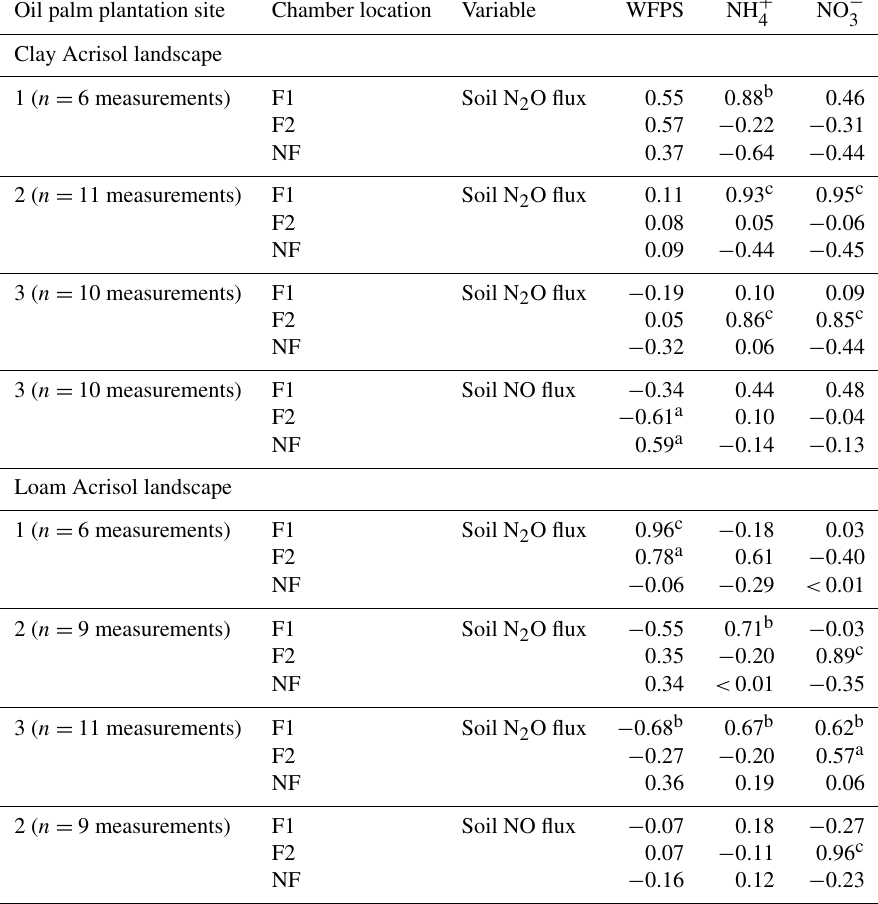
Table 4. Pearson correlation coefficients ( n = 6–11 measurements following fertilization) between N-oxide fluxes (µgNm − 2 h − 1 ), water- filled pore space (WFPS; %, top 0.05m depth) and extractable mineral N (mgNkg − 1 , top 0.05m depth), measured at different chamber locations (F1, F2 and NF were at 0.3m, with incidental fertilization; 0.8m, fertilized area; and 4–4.5m, non-fertilized area; respectively, from the stem base). The correlation was conducted using the means of the three replicate trees per chamber location on each sampling day following